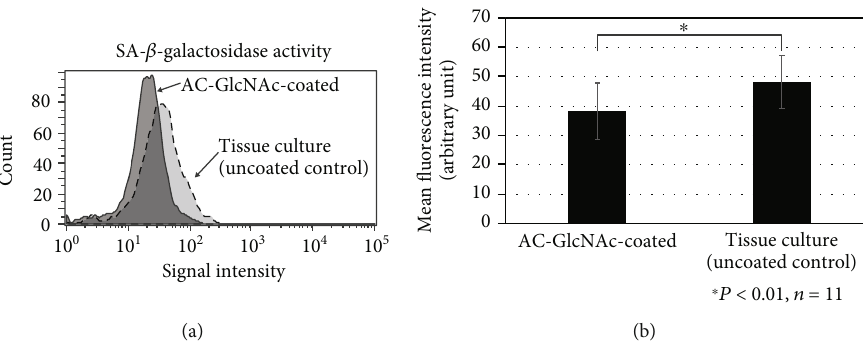
Figure 6: AC-GlcNAc-selected cells have reduced levels of the senescence marker SA- β -galactosidase. (a) Representative chart of fl ow cytometric analysis of SA- β -galactosidase activity. (b) SA- β -galactosidase activity.